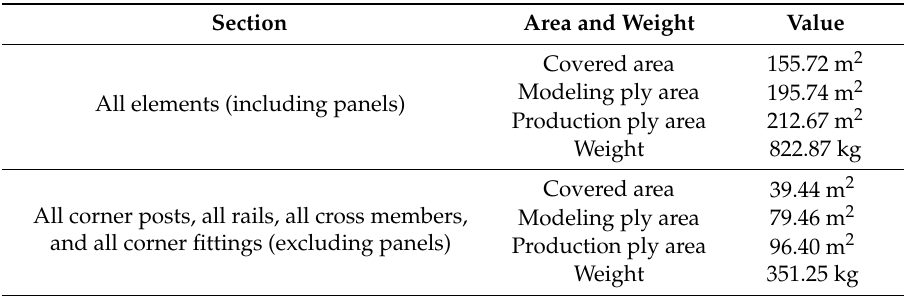
Table 3. Production values.